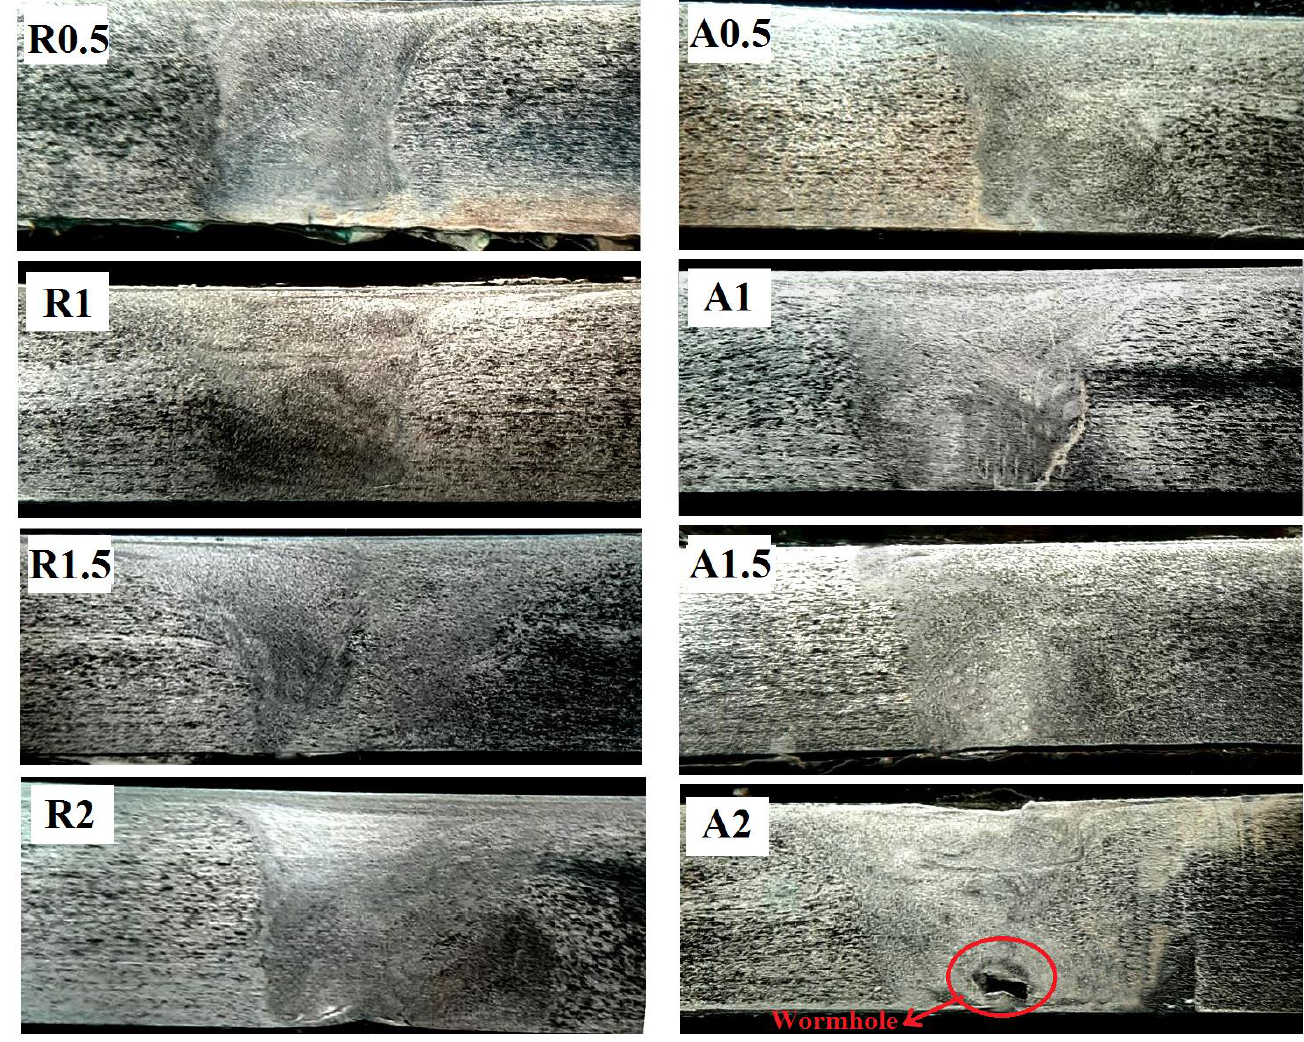
Figure 7. Welded section cross-section macrograph of AP-FSW and RP-FSW samples.